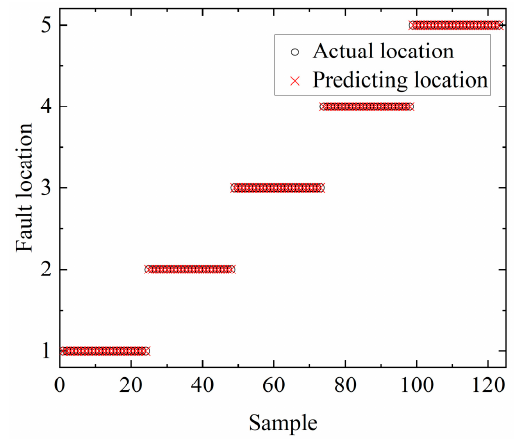
Figure 12. Test results of the DBN location test